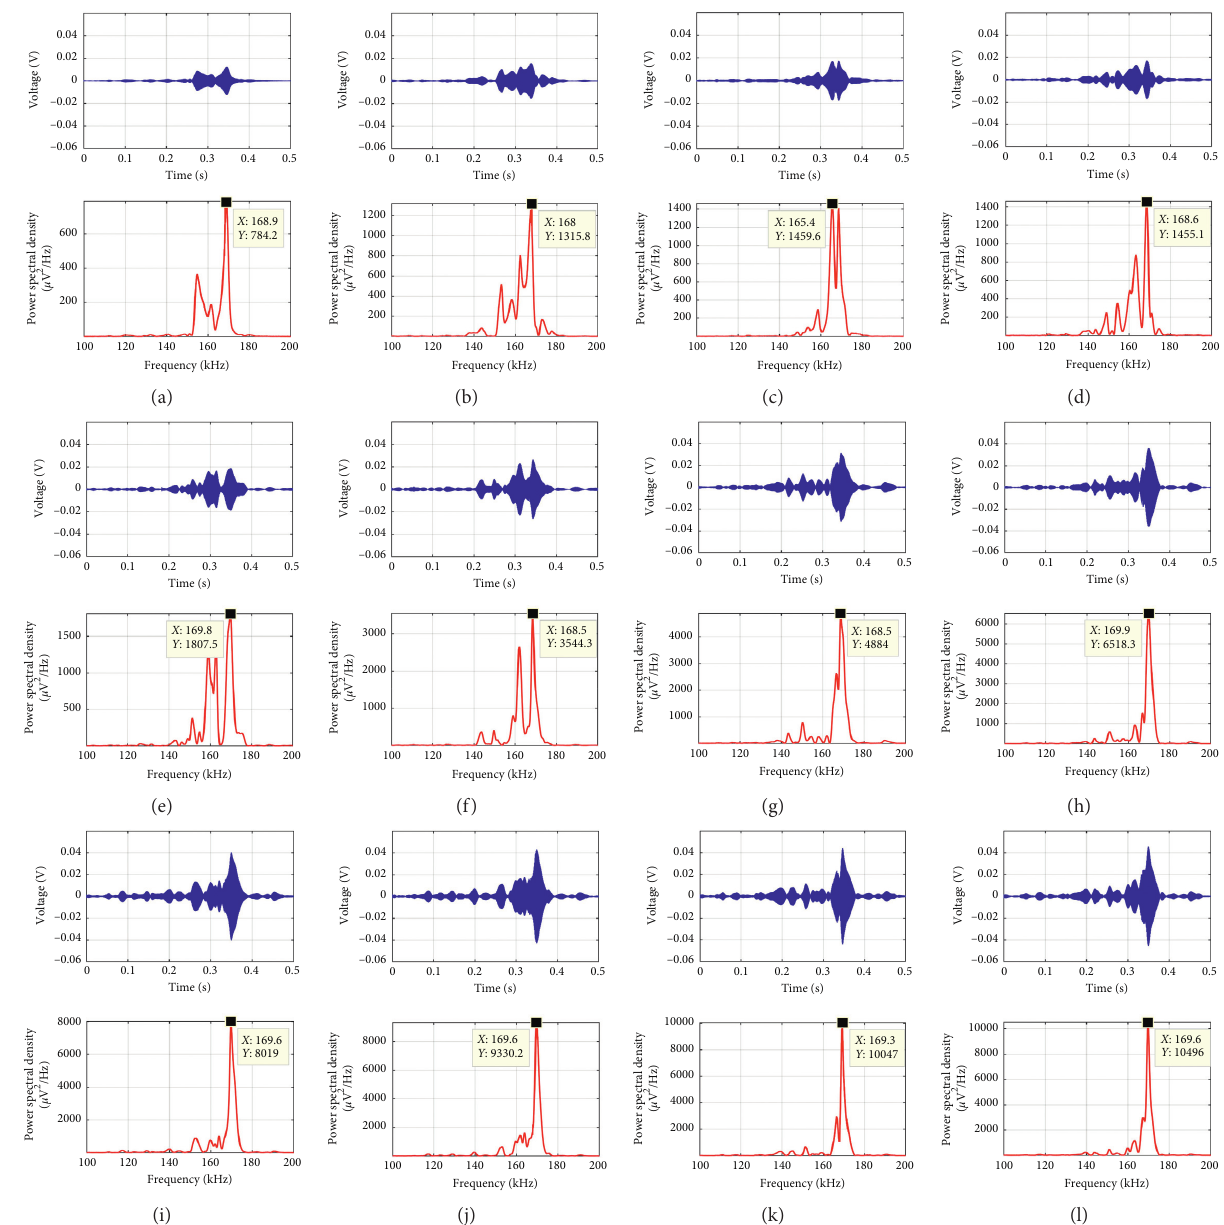
Figure 8: The power spectral density: (a) 1 d, (b) 3d, (c) 5d, (d) 7d, (e) 9 d, (f) 11d, (g) 13d, (h) 16d, (i) 19d, (j) 22d, (k) 25d, and (l)